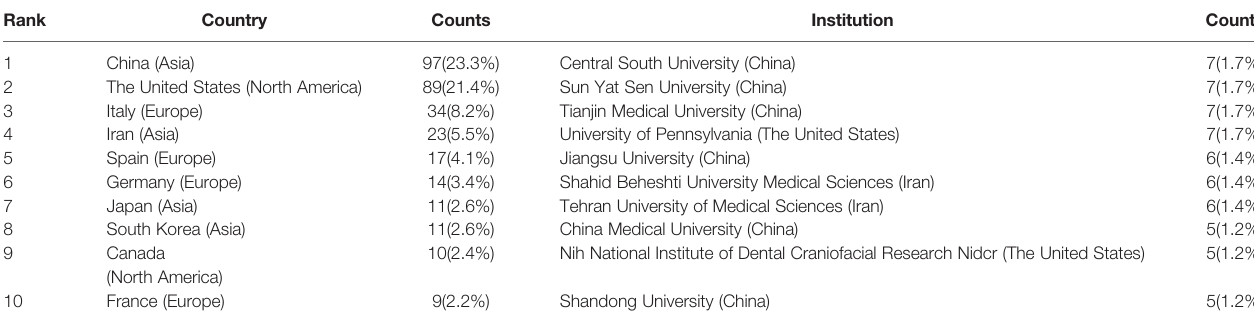
TABLE 1 | Top 10 countries and institutions on research of exosomes in AIDs. Rank